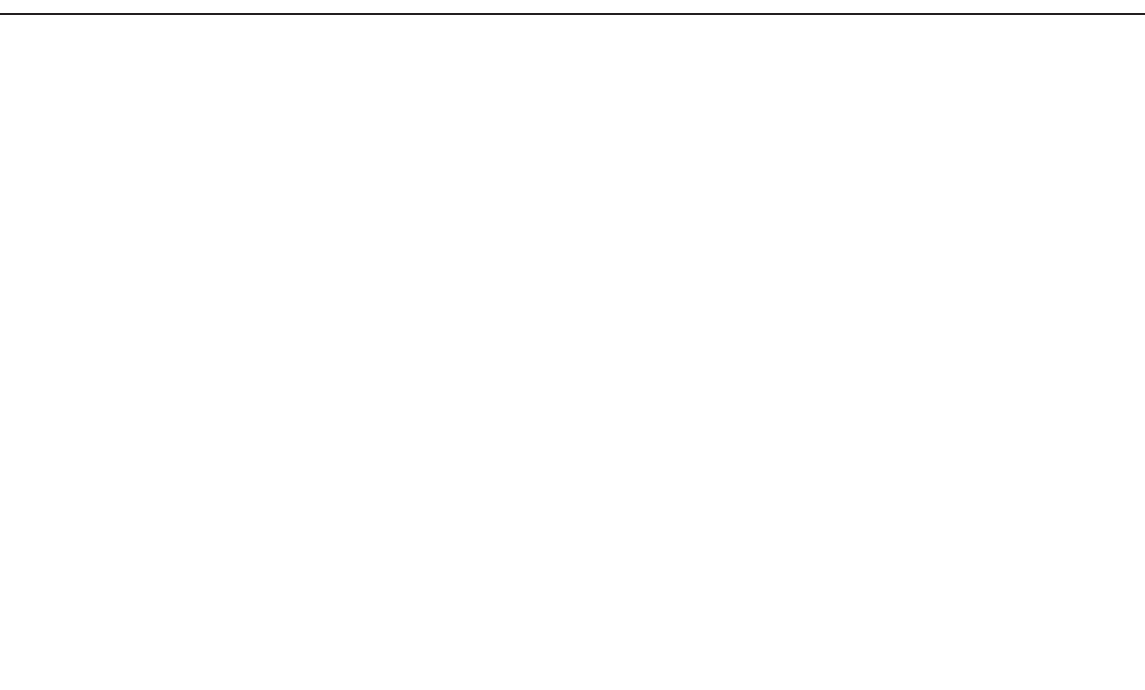
Fig.3: Amanita virosa another very poisonous mushroom which are commonly found in Katus-Chilaune forest in Nepal (Photo Courtesy Christensen, Sharma,